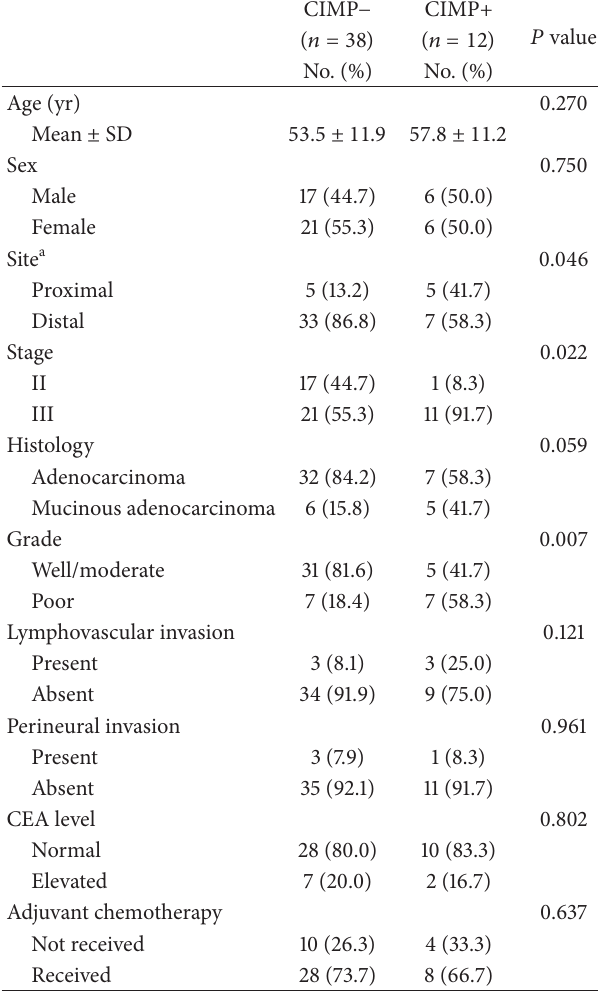
Table 1: Clinicopathological characteristics associated with CIMP